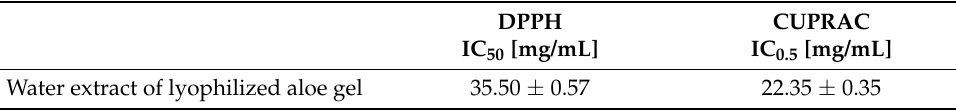
Table 2. The antioxidant effect of water extracts of lyophilized aloe